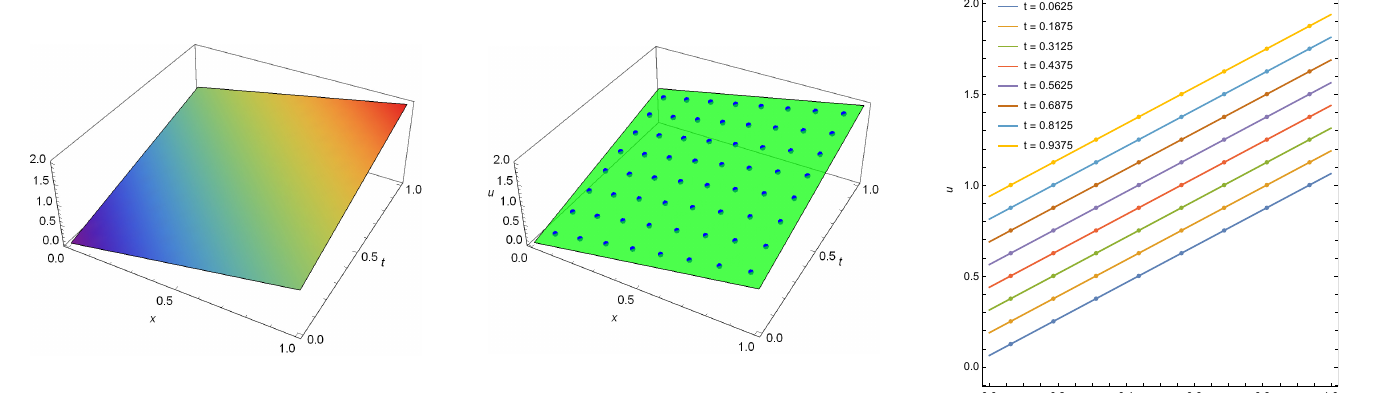
Figure 5. The exact solution ( left ) and numerical solution (points) with exact solution ( middle and right ) computed for Example 3 with M = 8, µ = 1, α =